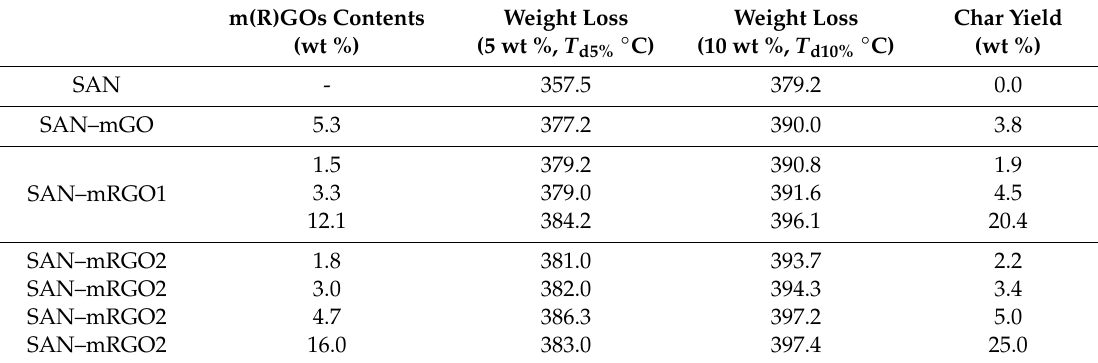
Table 2. Thermal stabilities of SAN, SAN–mGO, SAN–mRGO1 and SAN–mRGO2 at various contents of